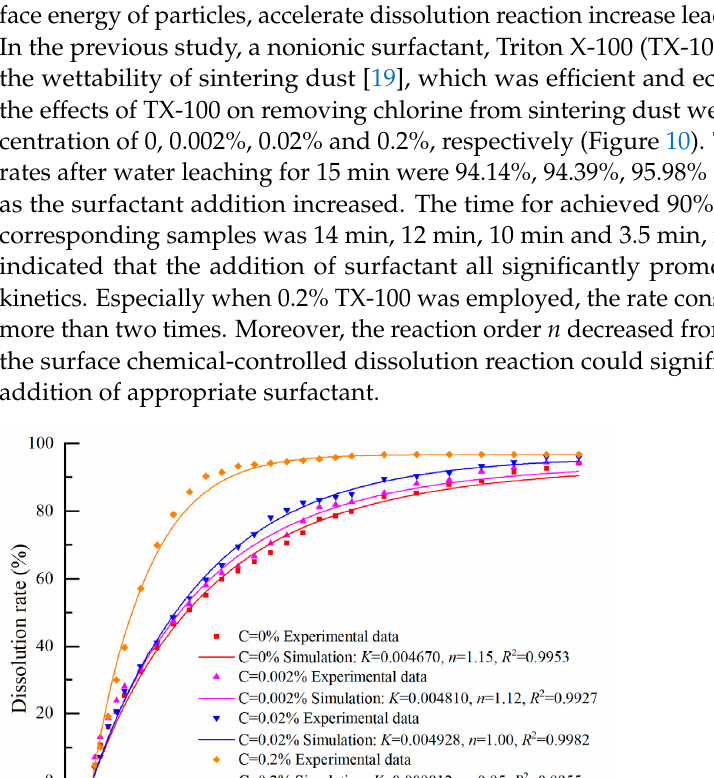
Figure 9. Effects of particle size on chloride ion dissolution rate with S/L ratio of 1:50 and stirring speed of 600 rpm at 25 °C.